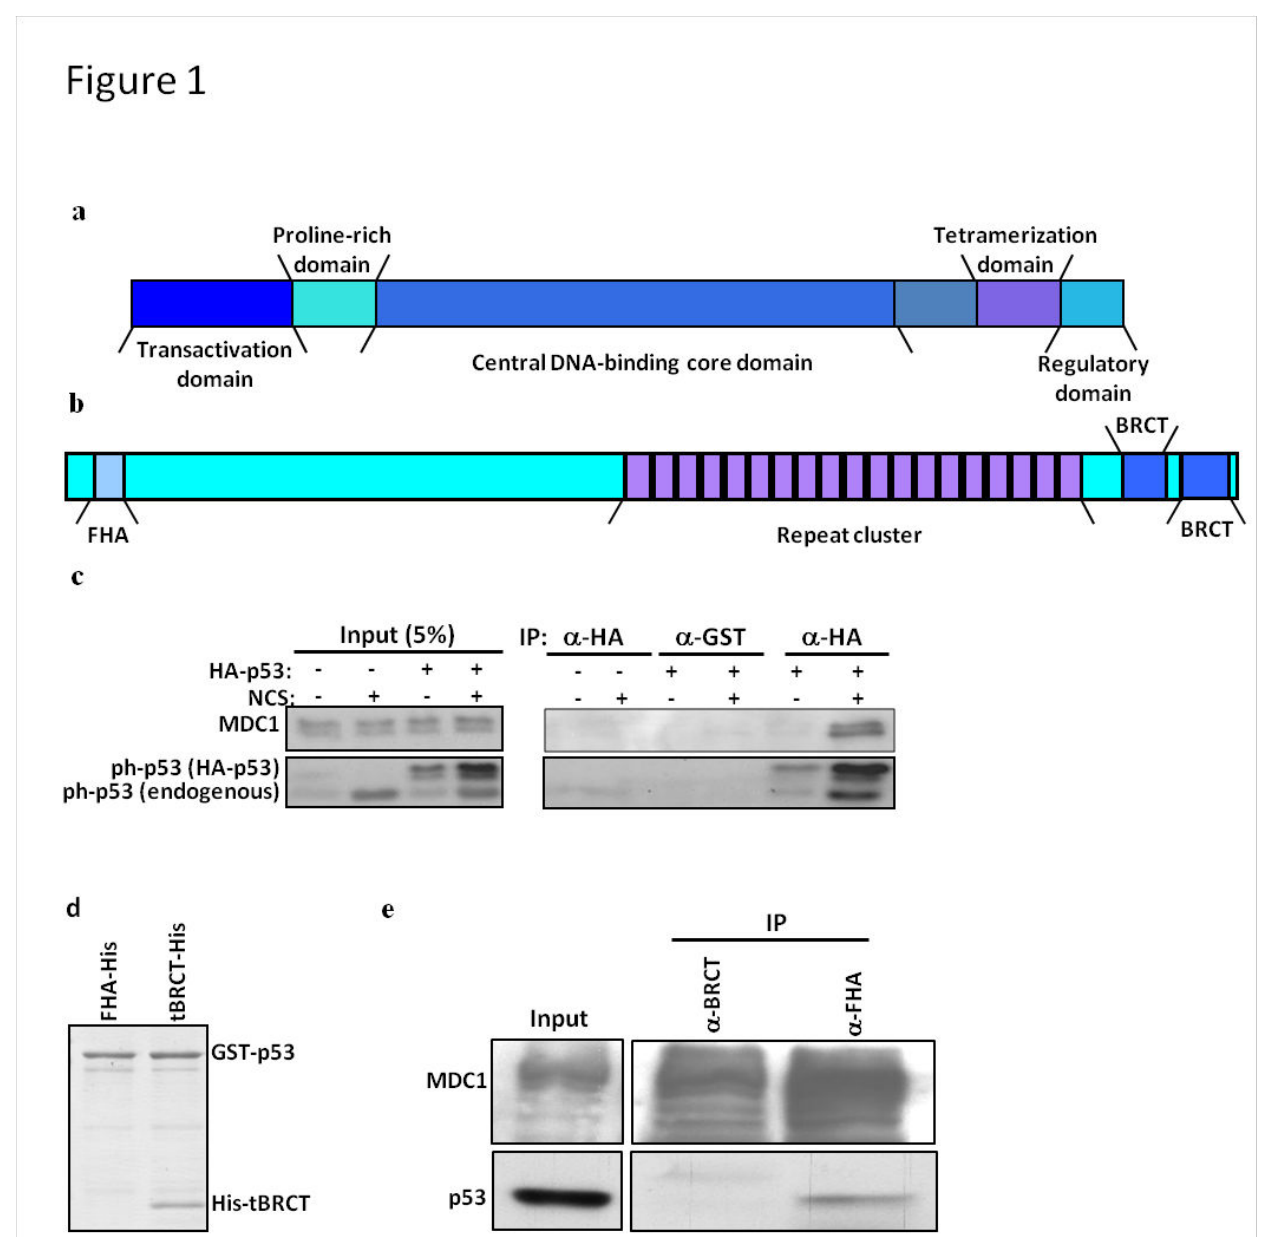
Figure 1. MDC1 and p53 interact following DNA damage through the tBRCT domain of MDC1. (a) A scheme of the different domains of p53. (b) A scheme of the different domains of MDC1. Note that in A, and B the images are not to scale as p53 is about 5 times smaller than MDC1. (c) 293T control cells transfected with empty vector or cells overexpressing HA-tagged p53 were either untreated (-) or treated with NCS (+). Following 1 hr incubation, the proteins were extracted and subjected to co-IP using anti-HA antibodies. Control for the co-IP was done with anti-GST antibodies. Detection was done using antibodies directed against endogenous MDC1 and phopsho-Ser15 of p53 (ph-p53). (d) The tBRCT domain of MDC1 directly interacts with p53. GST pull-down assay was performed with GST-p53 and His-tBRCT or His-FHA. All recombinant proteins were expressed in bacteria. Proteins were separated on a SDS gel and stained with Coomassie blue. (e) Endogenous p53 and MDC1 interact. Protein extracts prepared from 293 cells that were induced with 5 Gray of ionizing radiation and left for recovery for 1 hr were used in an IP experiment using antibodies directed against MDC1-tBRCT (α-BRCT) or against MDC1-FHA (α-FHA). Bound proteins were detected in Western blot using anti-p53 antibodies. Inputs present 5% of the extract used in the experiment.